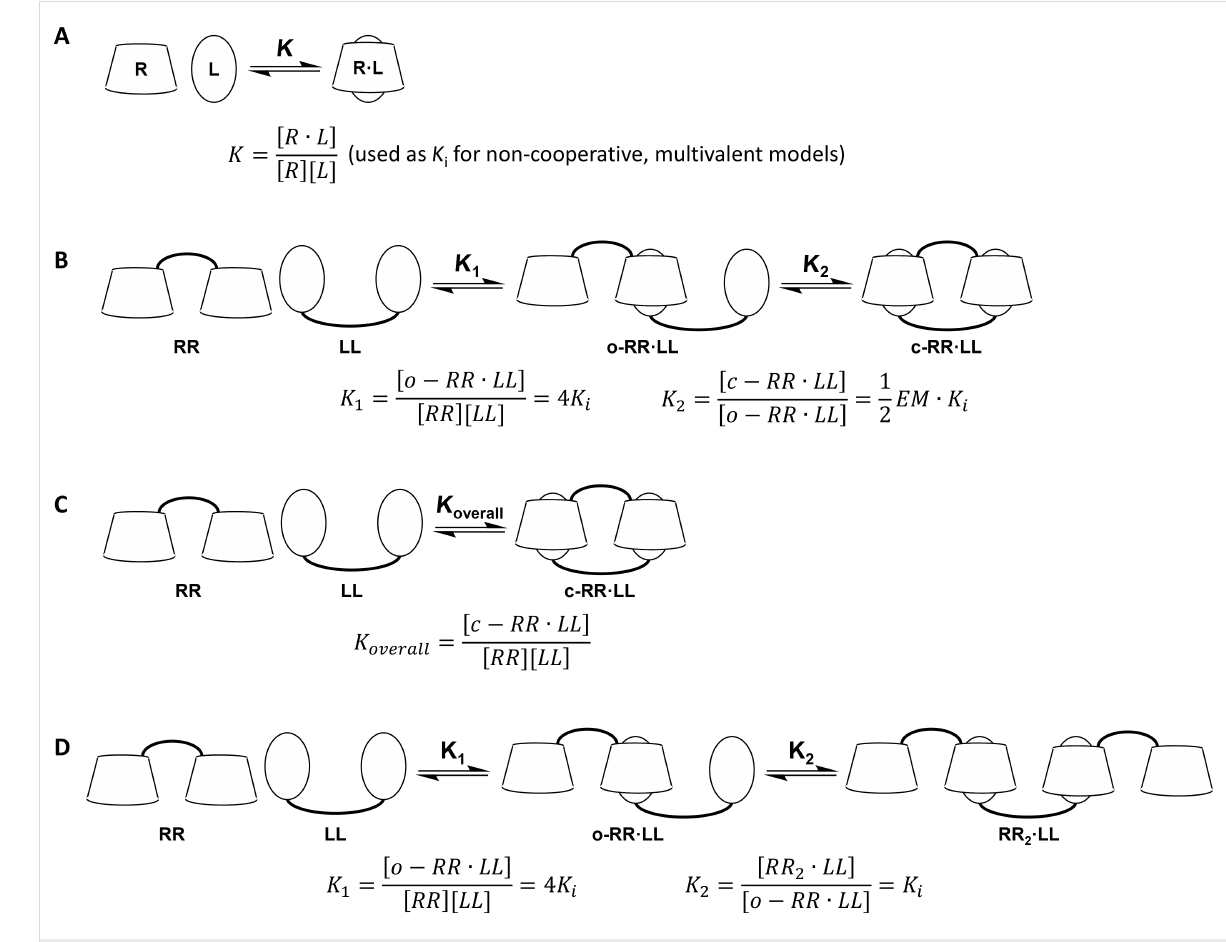
Figure 7: Selected binding models for the analysis of ITC data. (A) Monovalent receptor (R)-ligand (L) interaction. (B) Multivalent interaction of a diva- lent receptor (RR) and a divalent ligand (LL). (C) 1:1 overall interaction of a divalent receptor (RR) and a divalent ligand (LL). (D) 2:1 interaction of a divalent receptor (RR) and a divalent ligand (LL). EM = effective molarity. See Supporting Information File 2 for details.